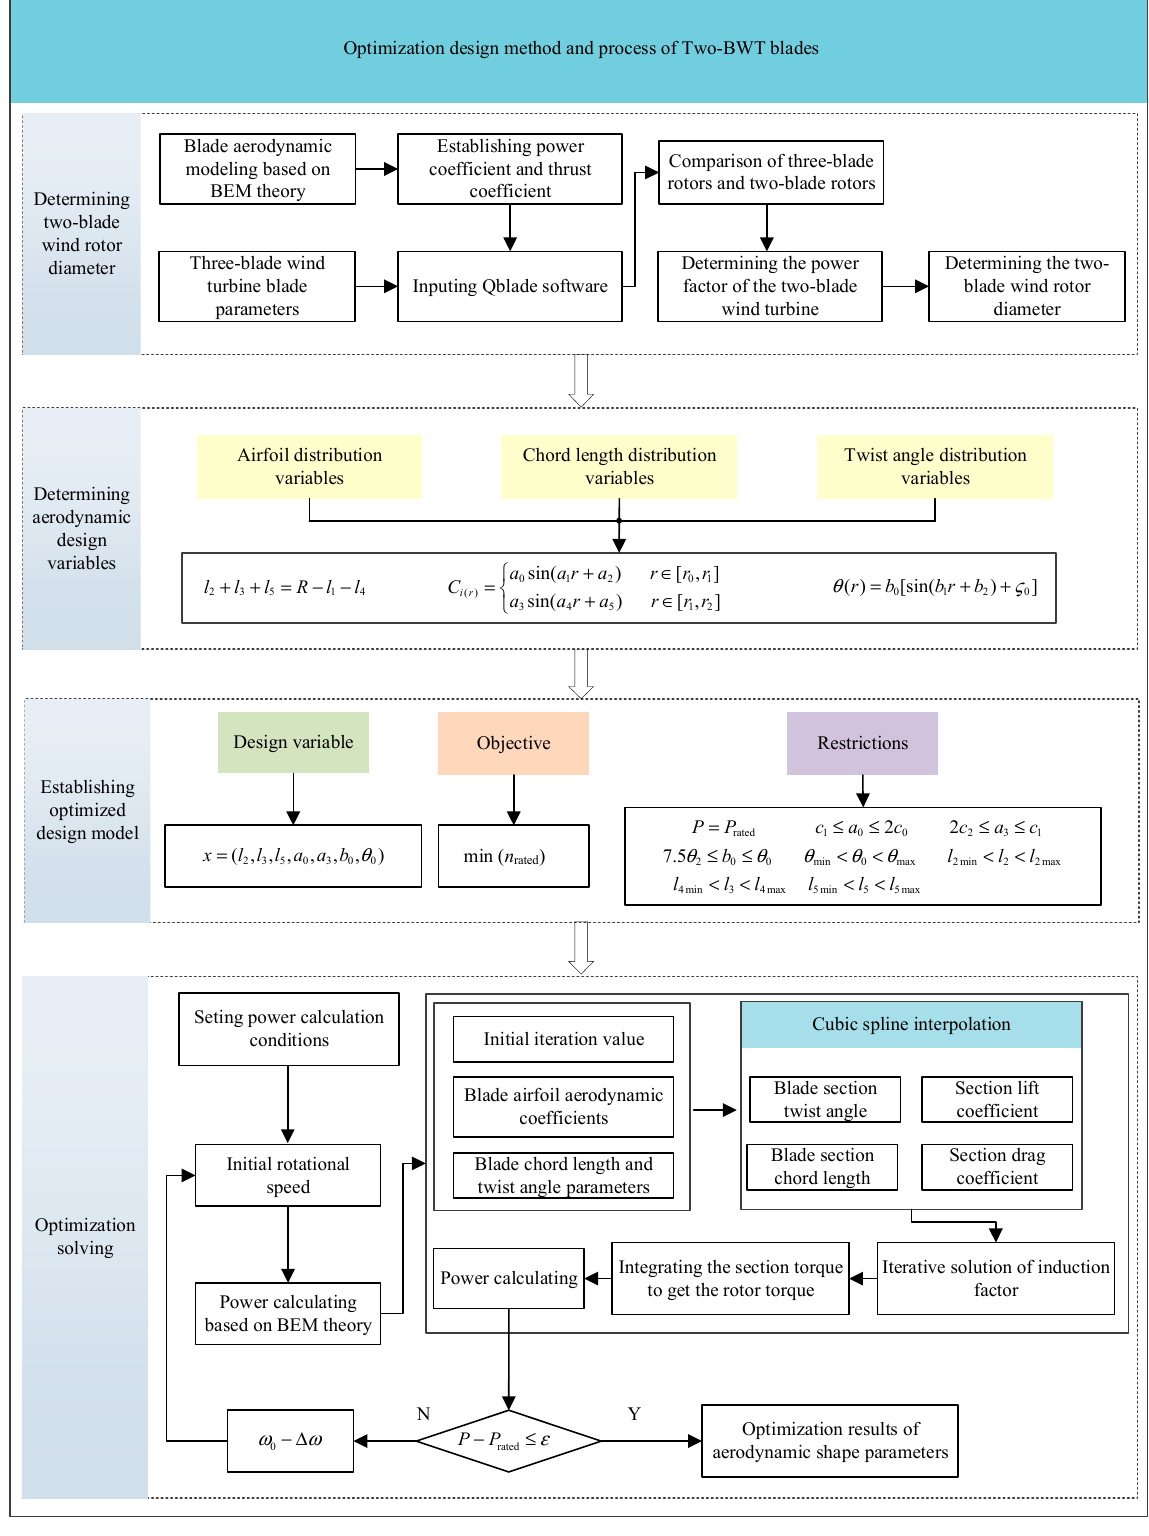
Figure 5. Optimization design method and process of the Two-BWT blades.